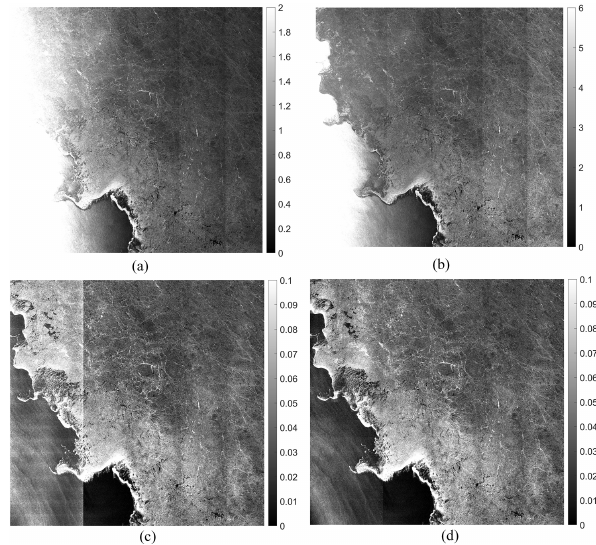
Figure 4. Examples of S1 EW images presenting the challenges in sea ice segmentation. (a) HH-polarized and (b) HV-polarized S1 EW images of a windy sea surface. (c) HH-polarized and (d) HV- polarized S1 EW images of a smooth thin ice surface. (Image ID: a and b S1A_EW_GRDM_1SDH_20190130T060740_ 20190130T060840_025703_02DB20_85BC; c and d S1B_EW_ GRDM_1SDH_20190115T194015_20190115T194115_